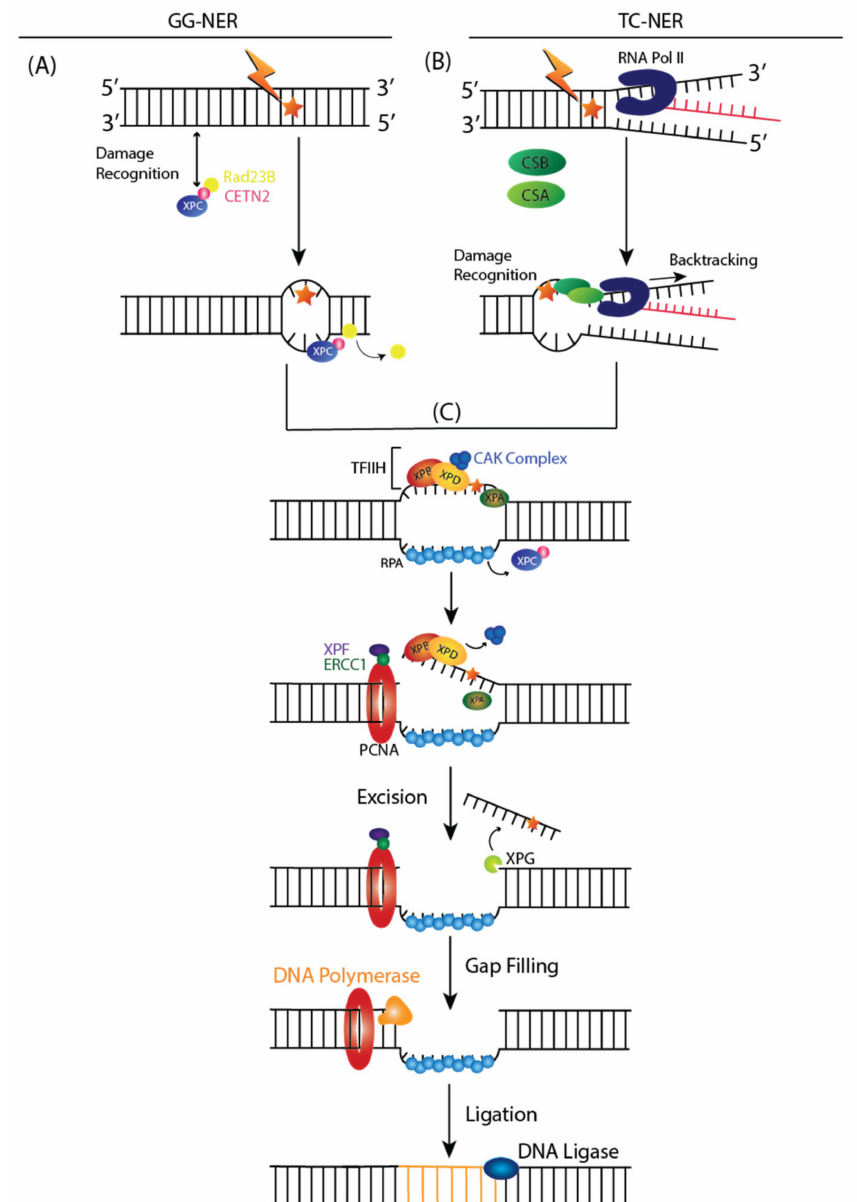
Figure 2. Nucleotide Excision Repair (NER) Subpathways: ( A ) Global Genome NER (GG-NER) and ( B ) Transcription-Coupled NER (TC-NER). ( A ) Helix distorting lesions are recognized with the help of XPC, Rad23B, and Centrin2 (CETN2). After XPC binds to the damage, Rad32B dissociates from the complex. ( B ) Damage is indirectly recognized by stalled RNA Pol II at the site of the lesion. CSB-CSA complex is formed, resulting in RNA Pol II backtracking to increase the accessibility of DNA lesions for repair. ( C ) In both GG-NER and TC-NER, the TFIIH complex is recruited post-lesion recognition. Upon binding of TFIIH, the CAK complex will dissociate from the core of the TFIIH, and the double helix further opens up around the lesion. XPD, XPA, and XPB will verify the existence of the lesions and binds to the single-stranded chemically altered nucleotide. RPA then coats the undamaged strand while XPF-ERCC1 heterodimer will create a 5 (cid:48) incision to the lesion. Then, XPG is activated and will cut the damaged strand 3 (cid:48) to the lesion, which excises the strand. PCNA will recruit DNA polymerases for gap-filling DNA synthesis and is finally sealed by DNA Ligase 1 or 3. The orange star denotes DNA